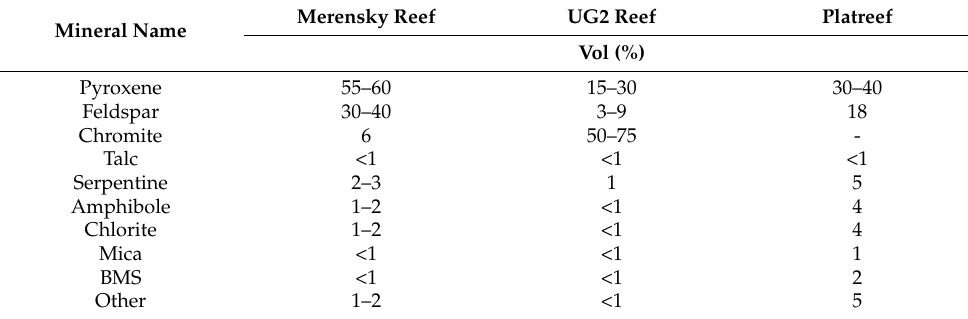
Table 2. Typical bulk mineral compositions of the Merensky, UG2 and Platreef [25].